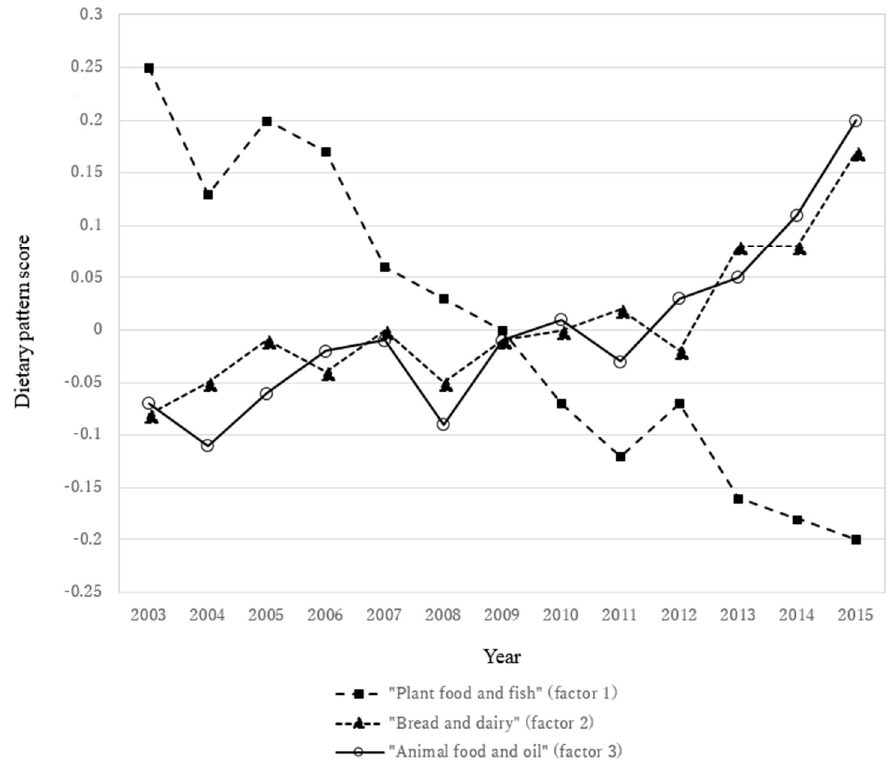
Figure 2. Thirteen-year trends in dietary pattern scores in adults aged ≥ 20 years in the National Health and Nutrition Survey, Japan 2003–2015. Values are means adjusted for sex, age category, occupation, weight status, and current smoking. The dietary pattern score represents standardized variables with mean 0 and standard deviation 1. Negative scores indicate low adherence to the dietary pattern, and positive scores indicate high adherence. The naming of the dietary patterns was as follows: “plant food and fish” (factor 1), “bread and dairy” (factor 2), and “animal food and oil” (factor 3). Sizes of the study population were as follows: n = 7062 for 2003, n = 5675 for 2004, n = 5469 for 2005, n = 6062 for 2006, n = 5954 for 2007, n = 6198 for 2008, n = 6047 for 2009, n = 5581 for 2010, n = 5197 for 2011, n = 19,717 for 2012, n = 5393 for 2013, n = 5298 for 2014, and n = 4874 for 2015. The trends in all dietary patterns were significant ( p for trend <0.0001).